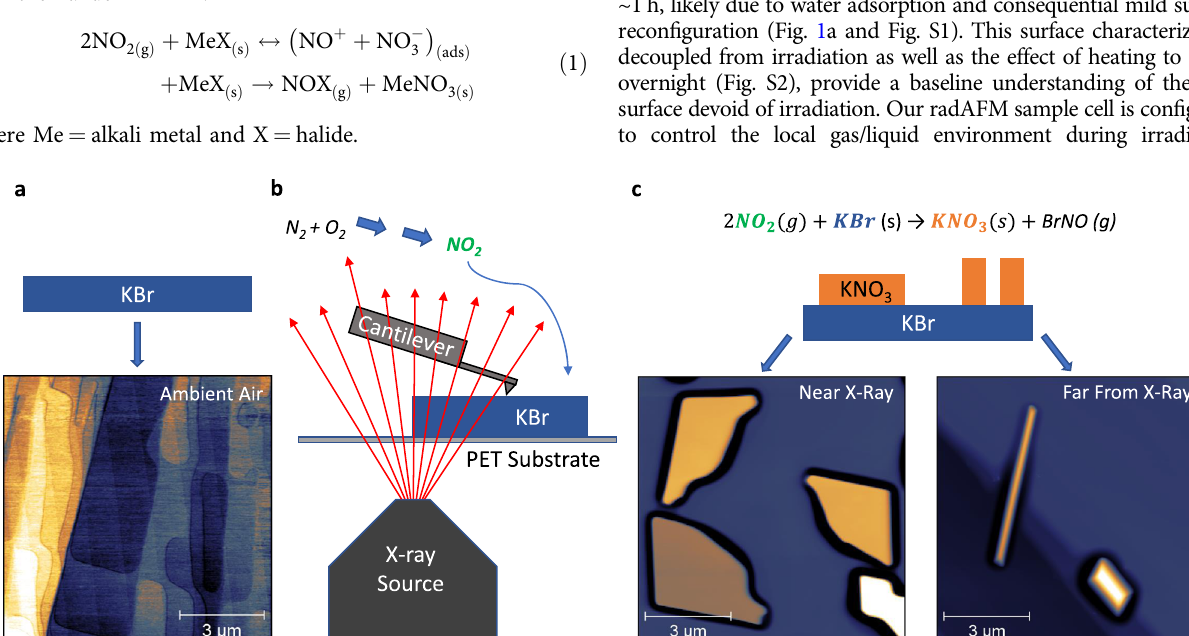
Fig. 1 Schematic of the KBr irradiation setup and proposed X-ray-induced reaction pathway. Freshly cleaved KBr (~3 × 3 × 1 mm) ( a ) is irradiated in a controlled atmosphere ( b ). X-rays penetrate a 0.25 mm polyethylene terephthalate (PET) substrate and react with air in a sealed reaction cell. Radiolitic products are generated, including NO 2 , which react with the KBr substrate and result in the growth of KNO 3 crystals. After irradiation with 400 kGy in an Ar/air mixture, the resulting volume and morphology of KNO 3 growth varies by proximity to the X-ray source ( c